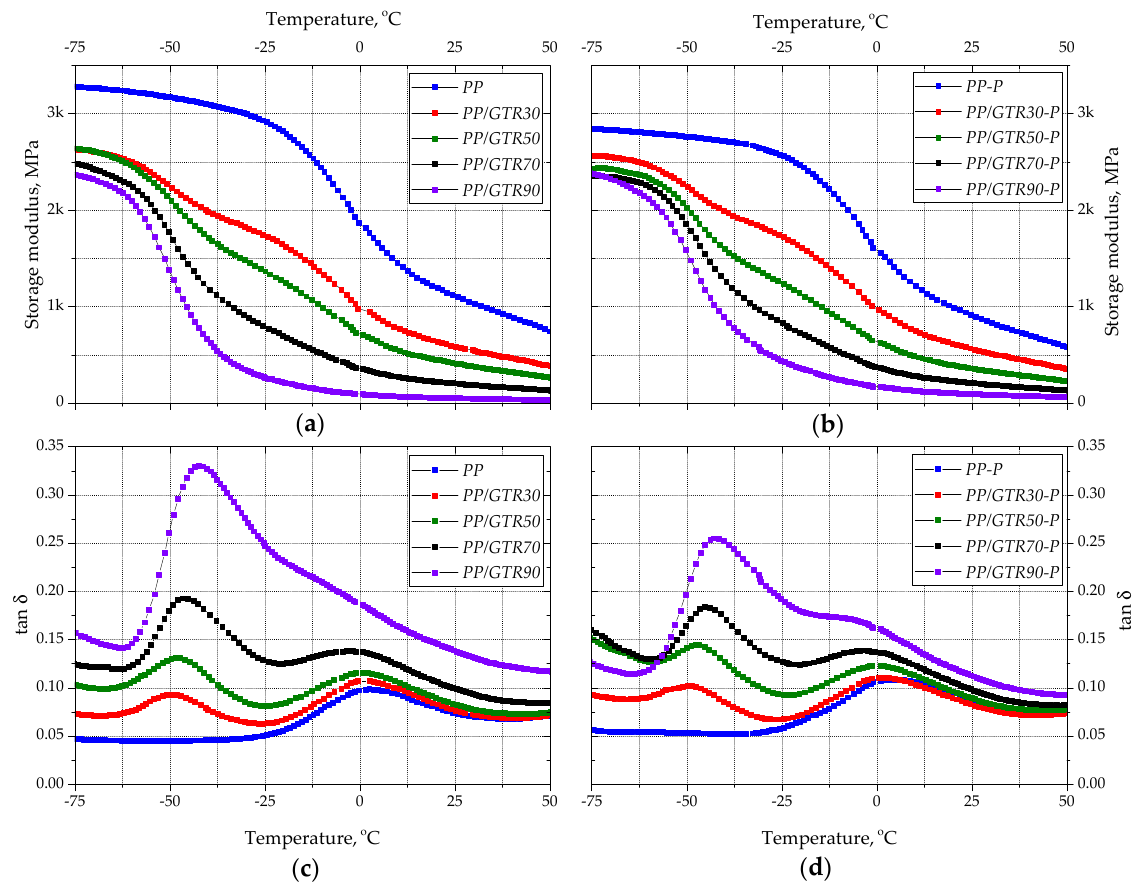
Figure 16. Viscoelastic properties of PP/GTR and PP/GTR-P compounds: storage modulus ( a , b ) and mechanical loss factor ( c , d ).